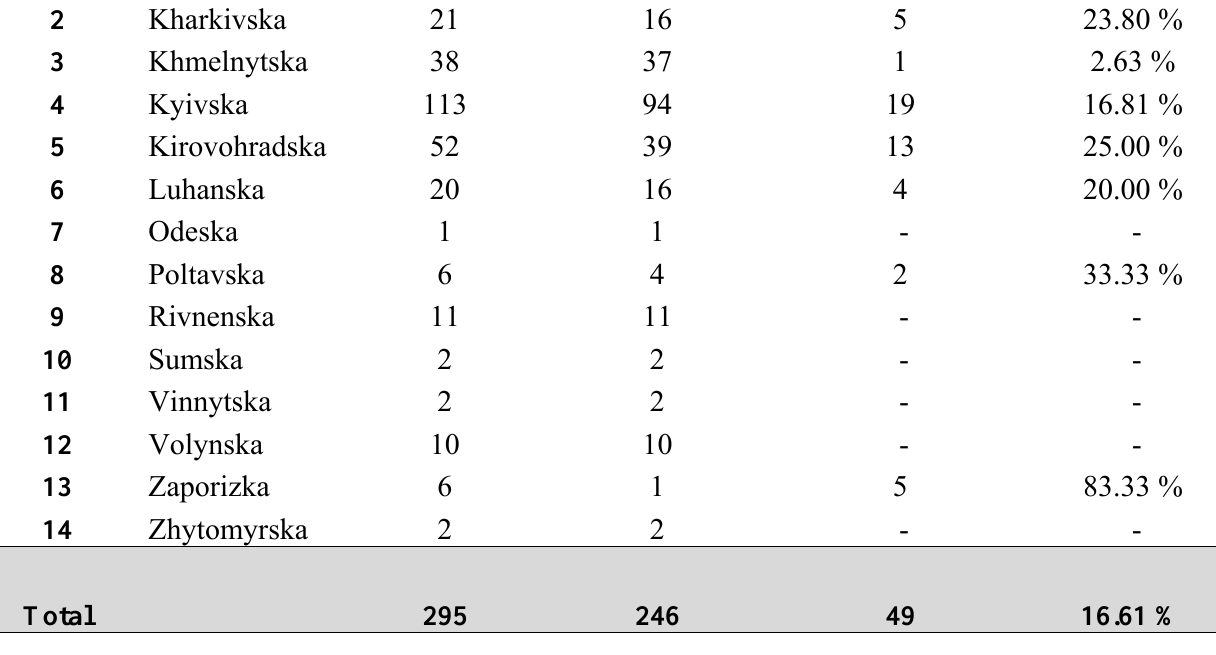
Figure 2. Competitive ELISA (S/N%) results of all 295 investigated horse sera. (1 = reactive samples, 2 = negative